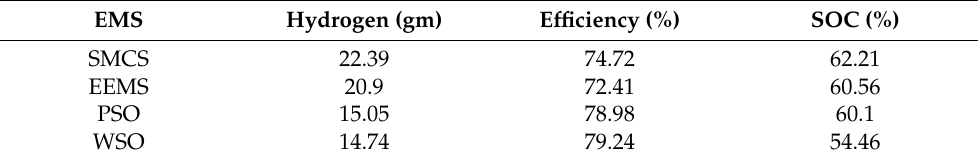
Figure 13. Time response of hydrogen consumption in gm obtained via each optimizer. Table 4. Performance of the planned EMS-PPA in comparison to alternative